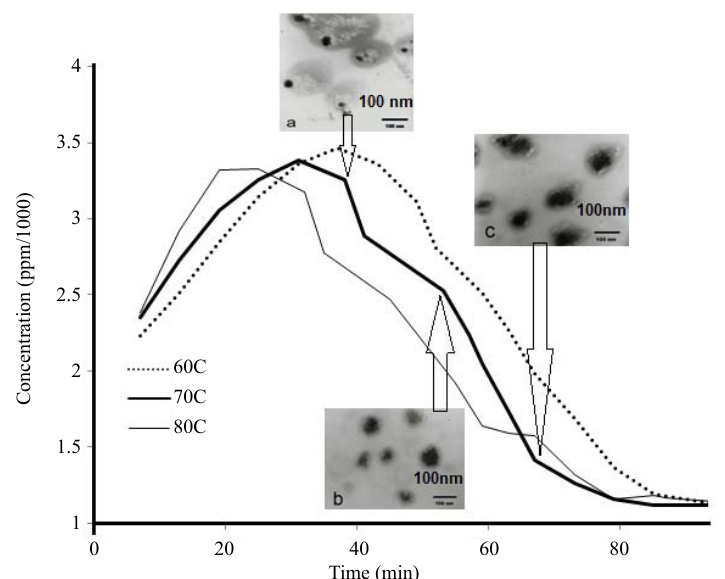
Fig. 5: Temperature effect on the nucleation and growth of TiO